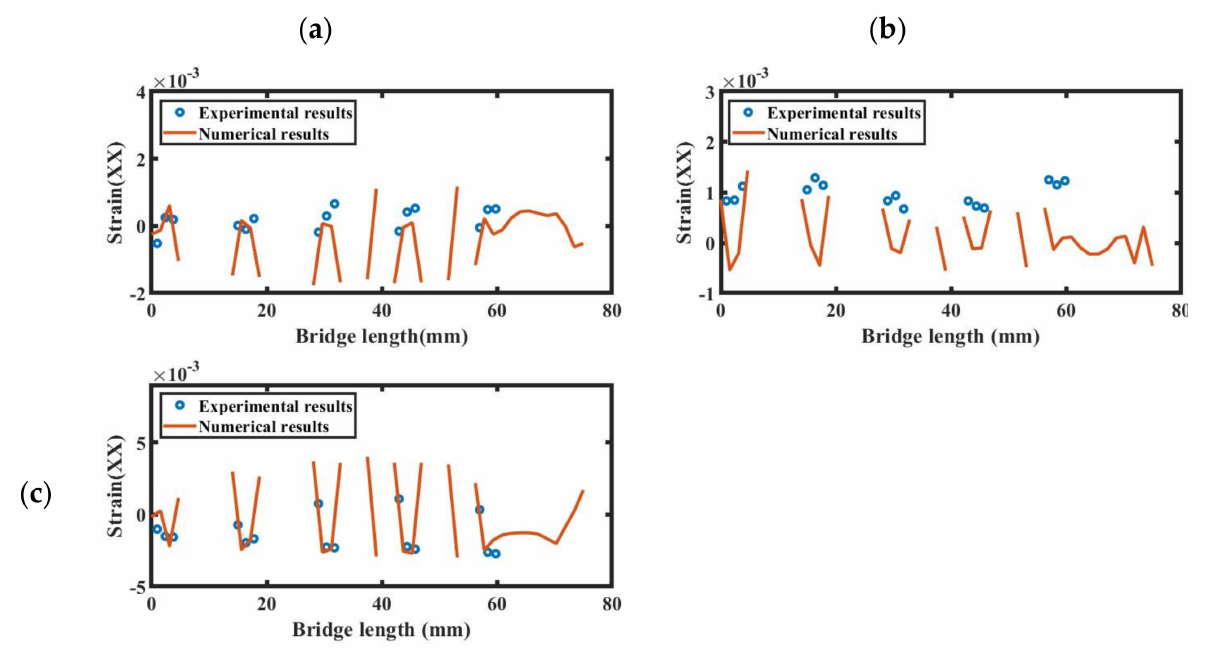
Figure 10. The ( a – c ) represents the comparison of experimental and simulation residual strain at z = 2.216 in the x, y and z-directions